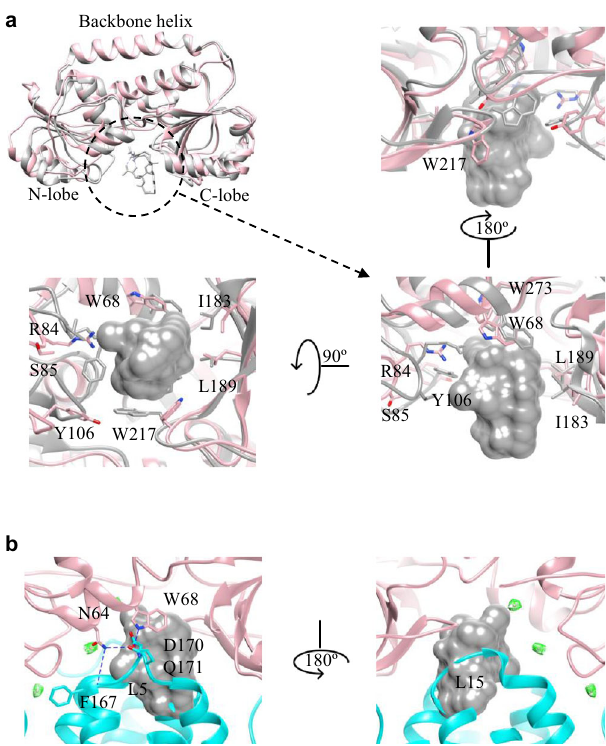
Fig. 3 Deformed substrate-binding pocket in FhuD. a Superimposed FhuD structures from FhuCDB (pink) and gallichrome-bound FhuD (PDB:1EFD, gray) with substrate-binding residues shown in zoomed-in views. b Substrate-binding pocket in FhuD is occupied by two FhuB loops L5 and L15 (cyan) with speci fi c hydrogen bonds (blue). Experimental densities of trapped water molecules are shown in mesh